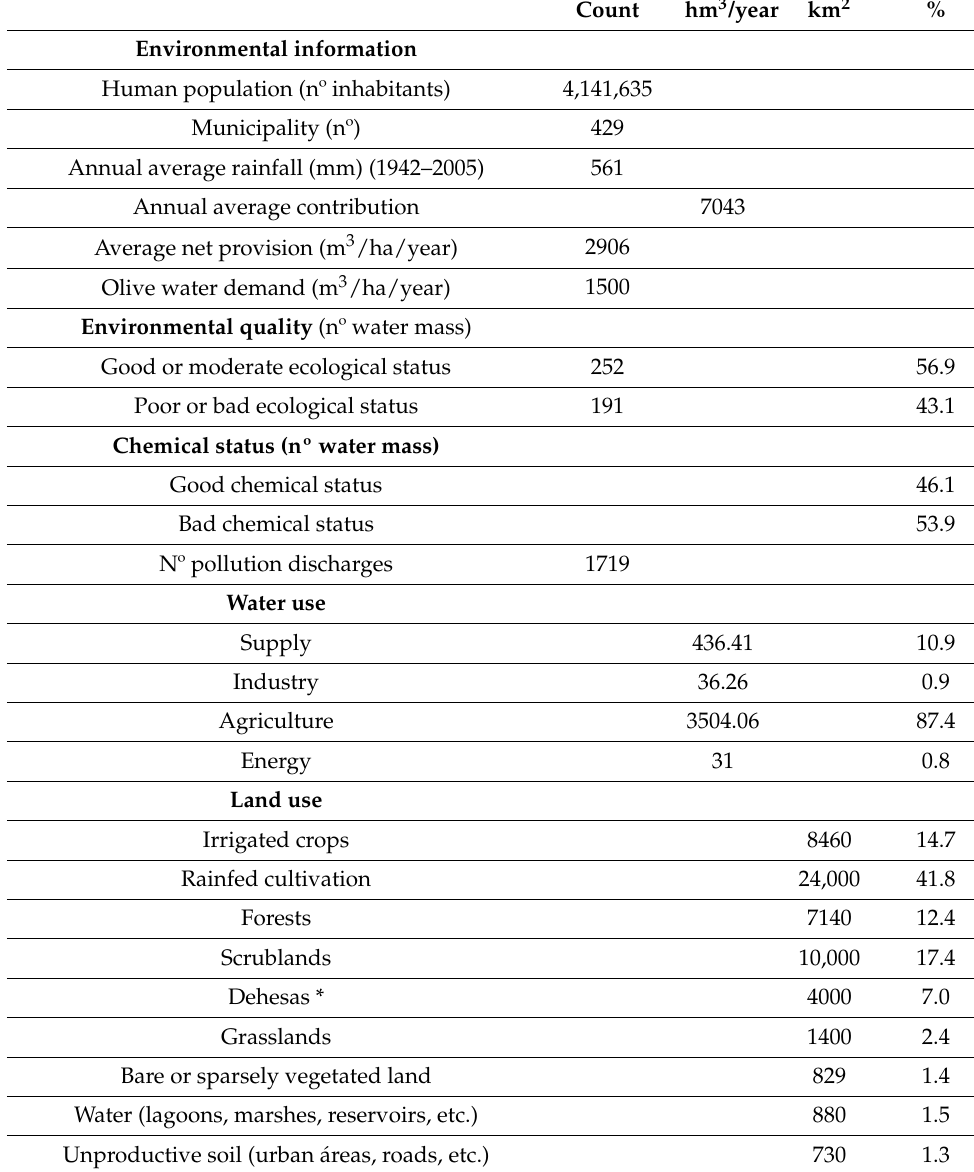
Guadalquivir River Basin environmental characteristics (data source: Confed- eraci ó n Hidrogr á fica del Guadalquivir: http://www.chguadalquivir.es/demarcacion-hidrografica- guadalquivir#PlanHidrologicodelGuadalquivir2009-2015 (accessed on 23 July 2021). * ‘Dehesa’ is a particular Mediterranean ecosystem where man has removed bushes to improve the farm